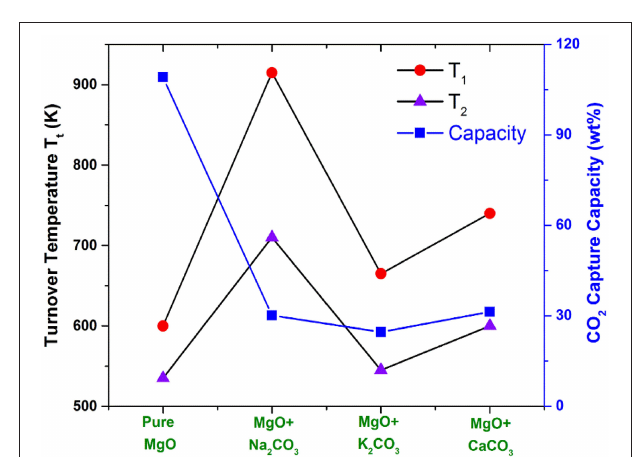
FIGURE 3 | The calculated turnover temperatures and CO 2 capture capacity vs. molar percentage of SiO 2 or ZrO 2 in the lithium silicates or zirconates. T 1 are the turnover temperatures under pre-combustion conditions with CO 2 partial pressure at 20 bars, while T 2 are the turnover temperatures under post-combustion conditions with CO 2 partial pressure at 0.1 bar.